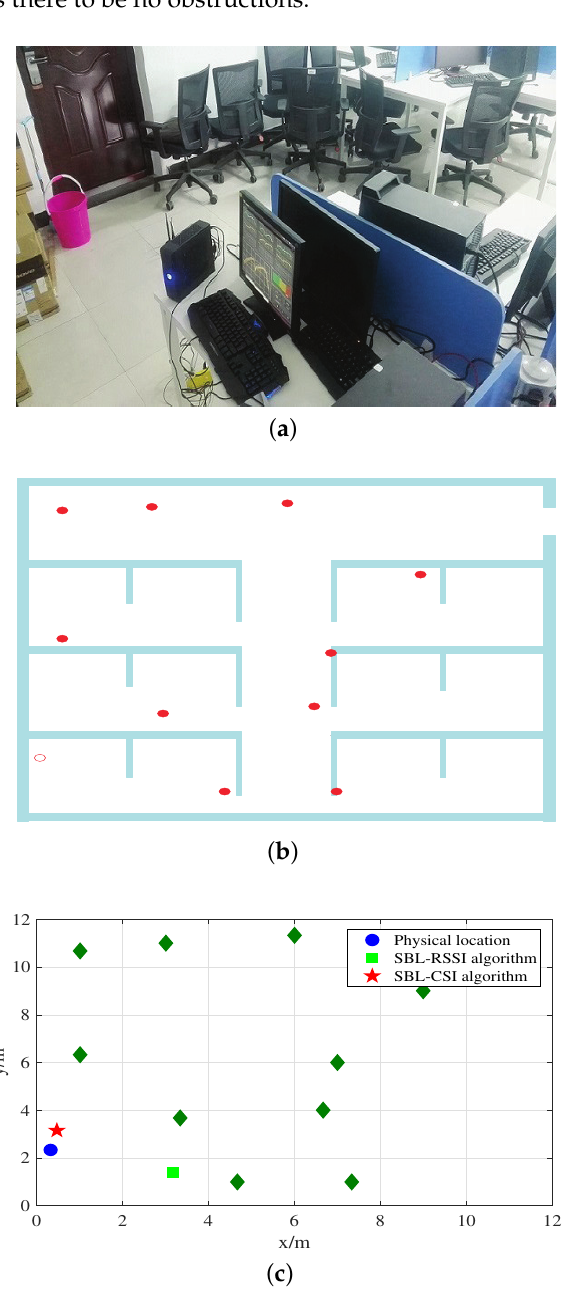
Figure 8. ( a ) Diagram of the experimental scene. ( b ) Diagram of the experimental area. ( c ) Diagram of the ordinary APs and the